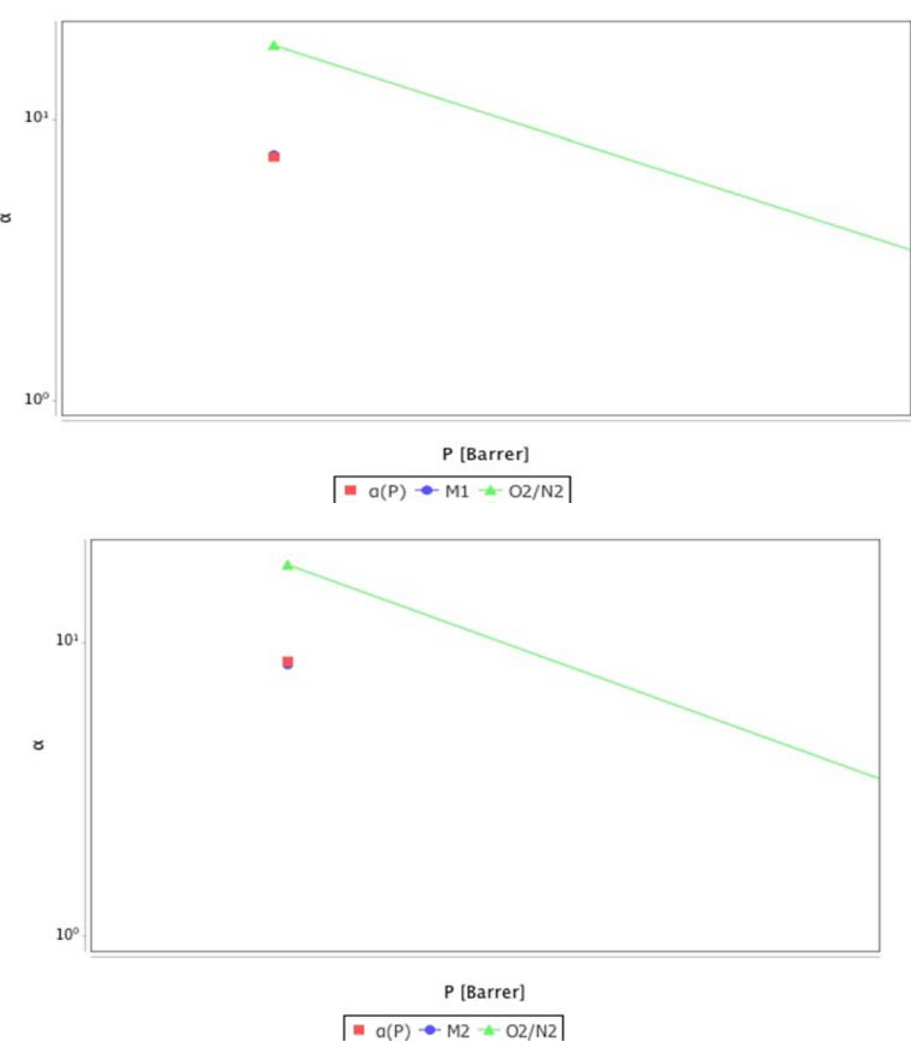
Table 2. Experimental [39] and theoretical MOT-predicted data for the zeolite 4A-Ultem mixed-matrix